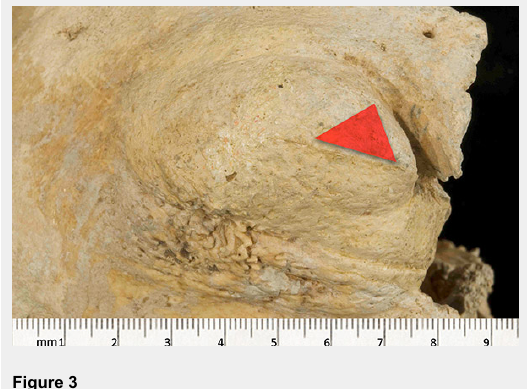
Location of sampling for histological analysis (red triangle).